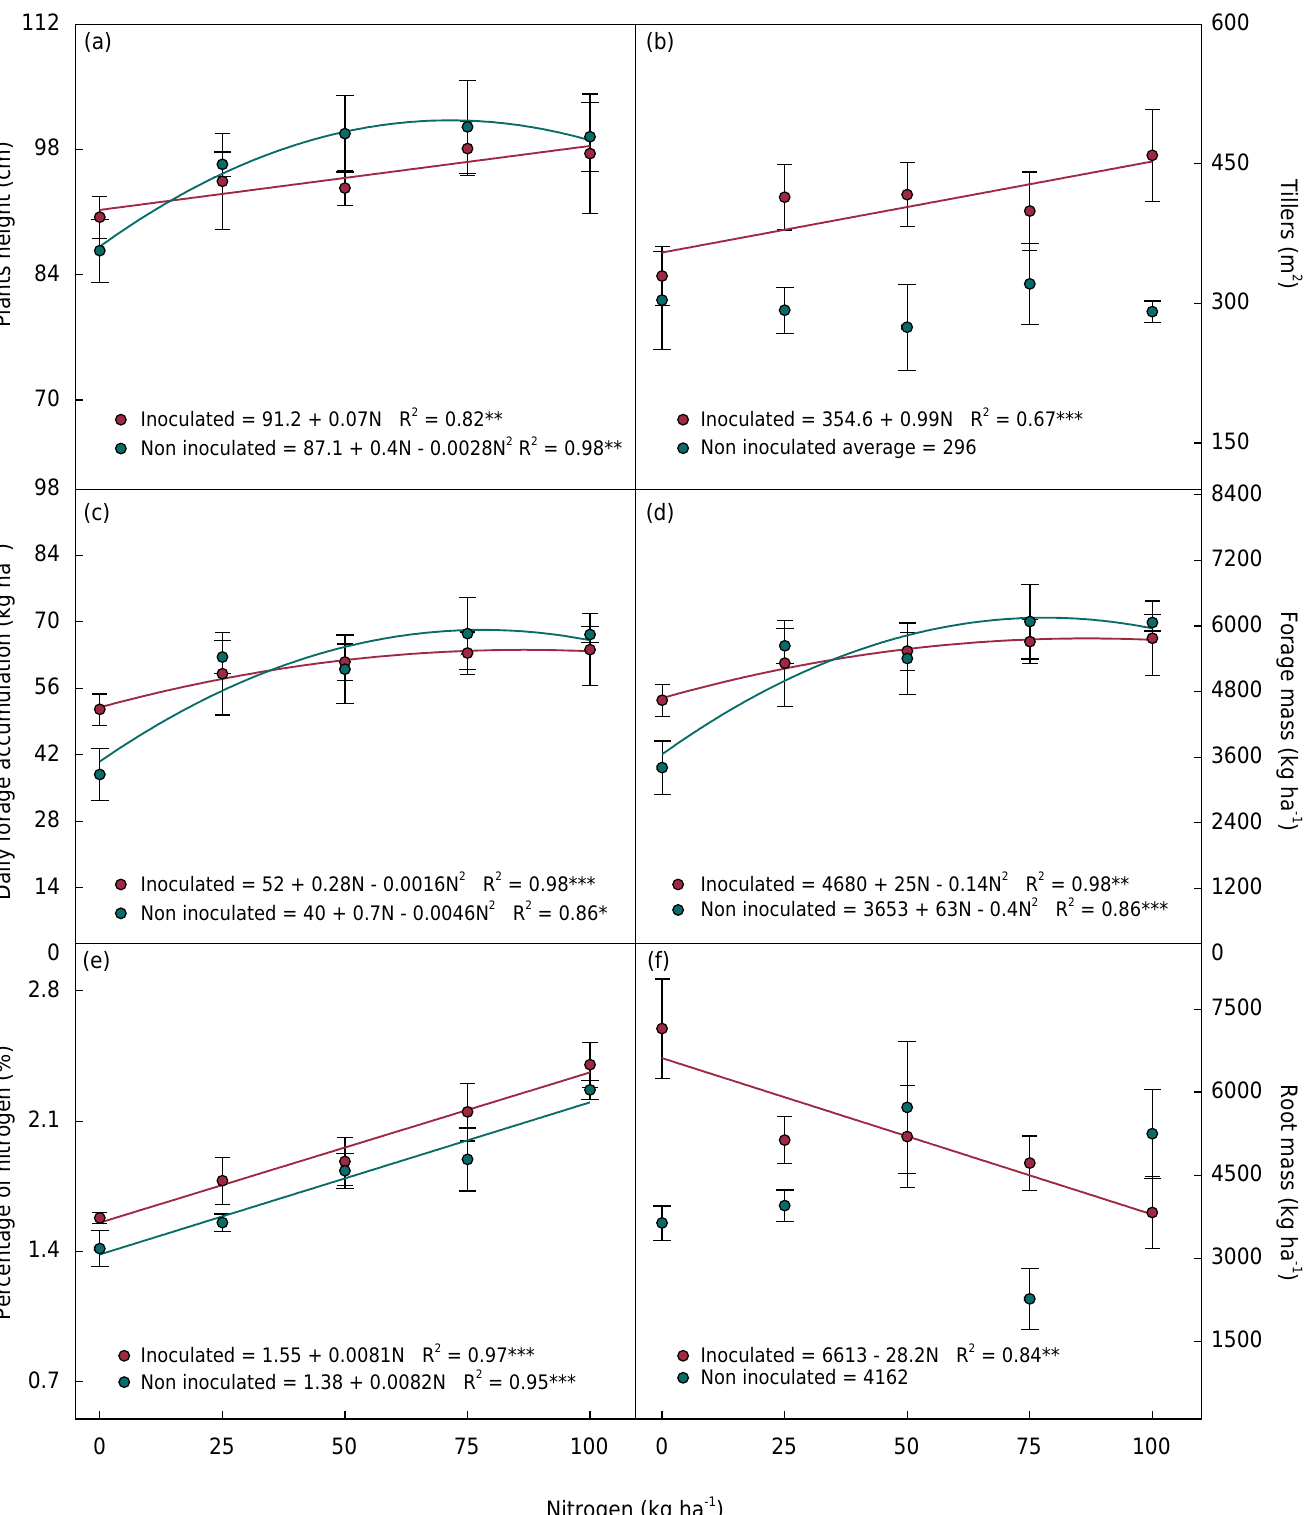
Figure 4. Plant height (a), number of tiller (b), daily forage accumulation (c), forage mass (d), percentage of nitrogen (e), and root mass (f) of mombaça grass at doses of nitrogen for inoculated and non-inoculated